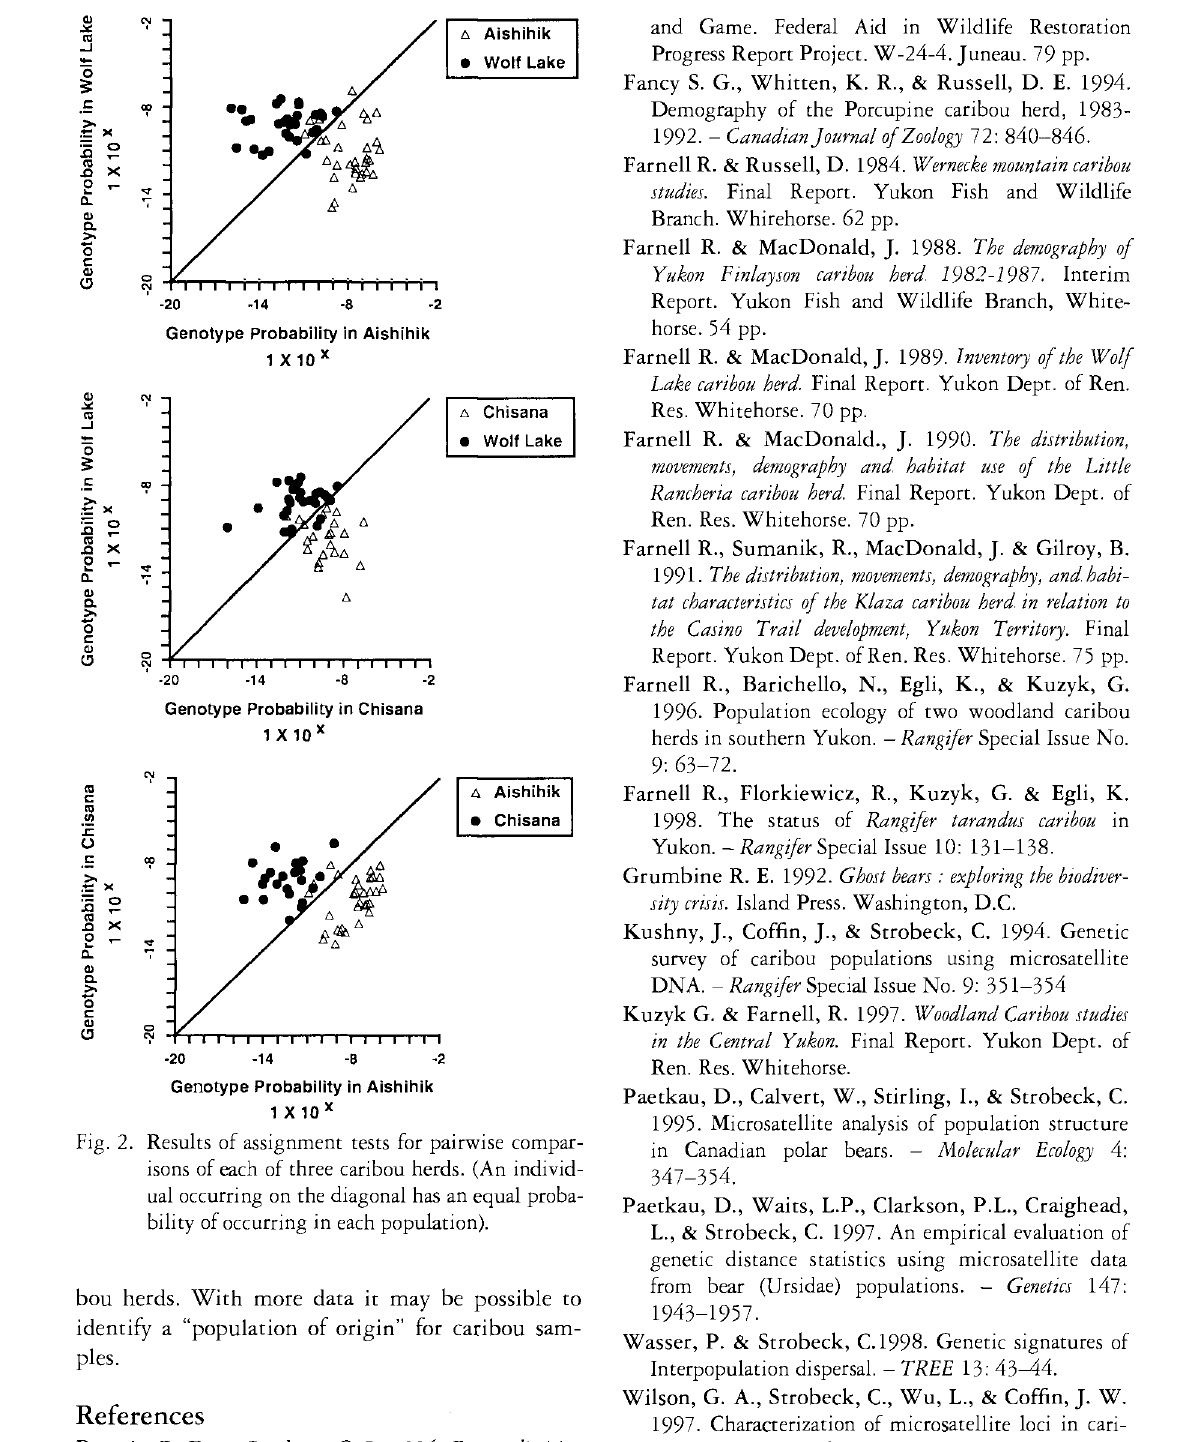
bou herds. With more data it may be possible to identify a "population of origin" for caribou sam